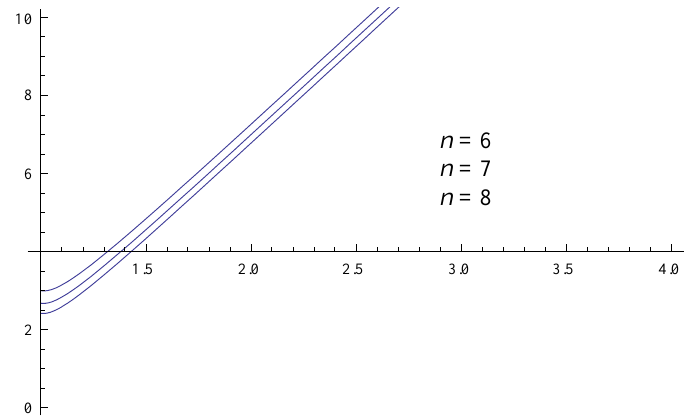
Figure 3. The impact of parameter n on the MRL of the C ( k,d,n )